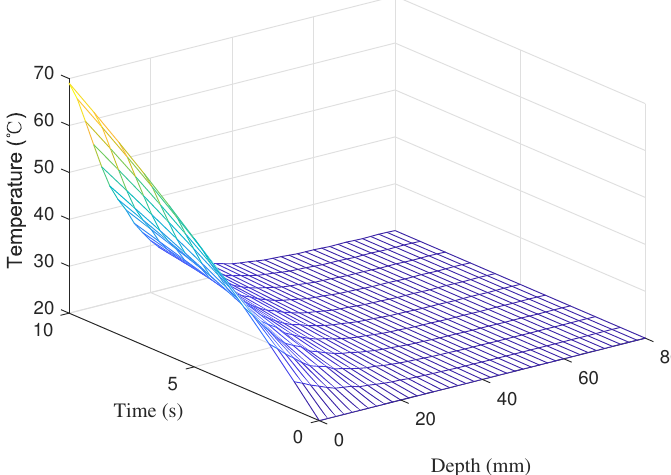
Figure 8. The global temperature distribution calculated by the FEM at x = x 0 /2.